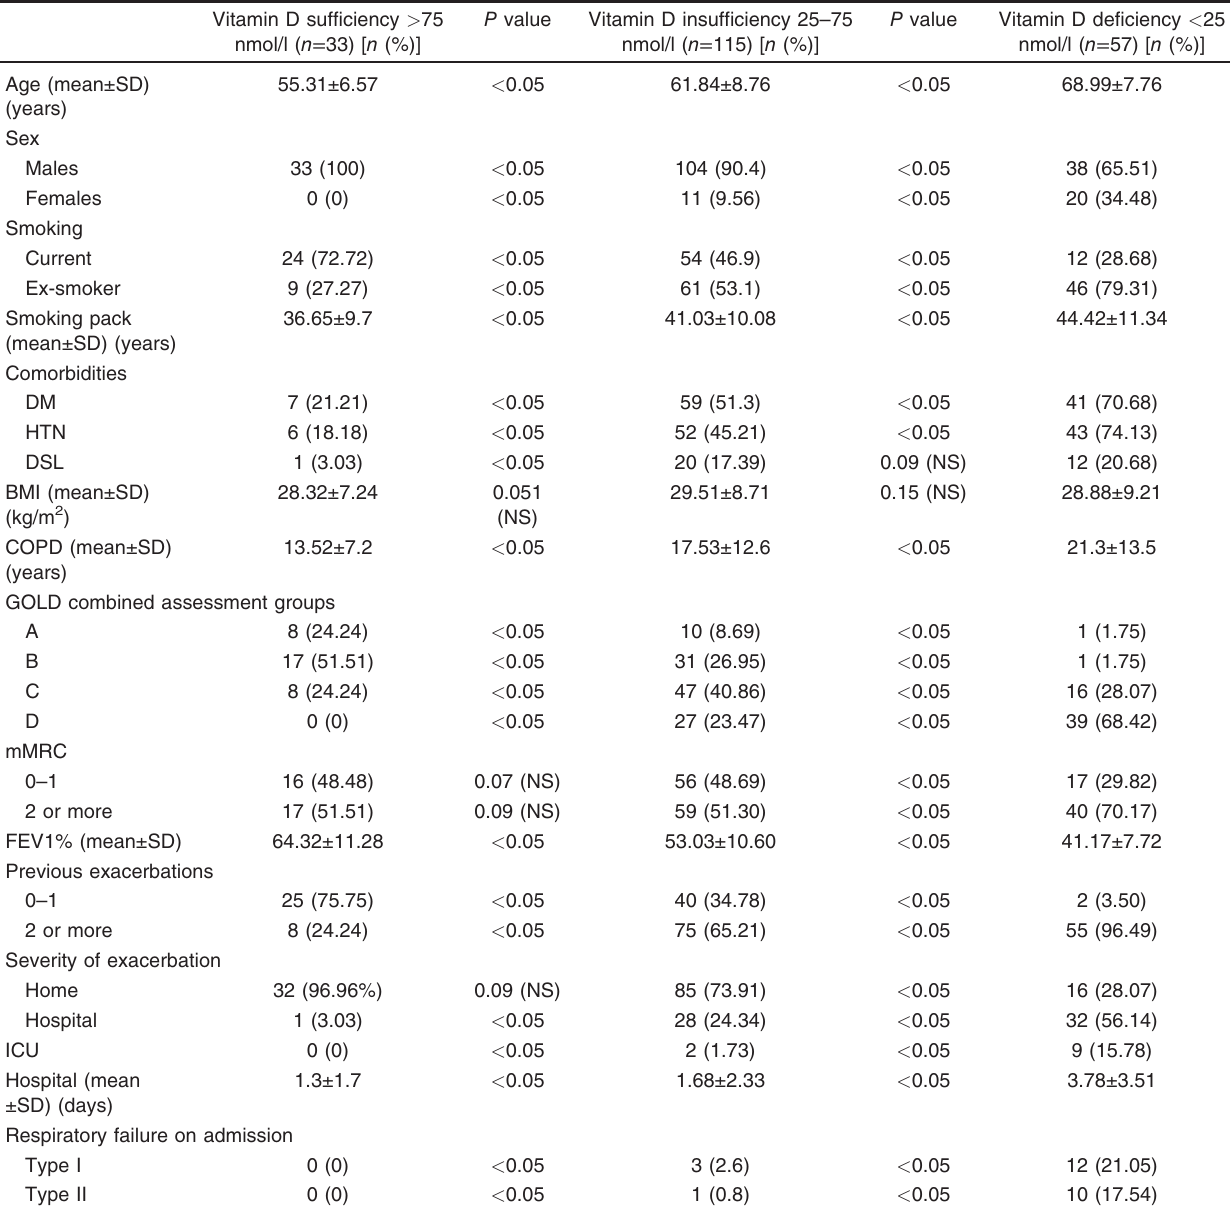
Table 4 Categorization of patients with chronic obstructive pulmonary disease based on vitamin D status of sufficient, insufficient, and deficient